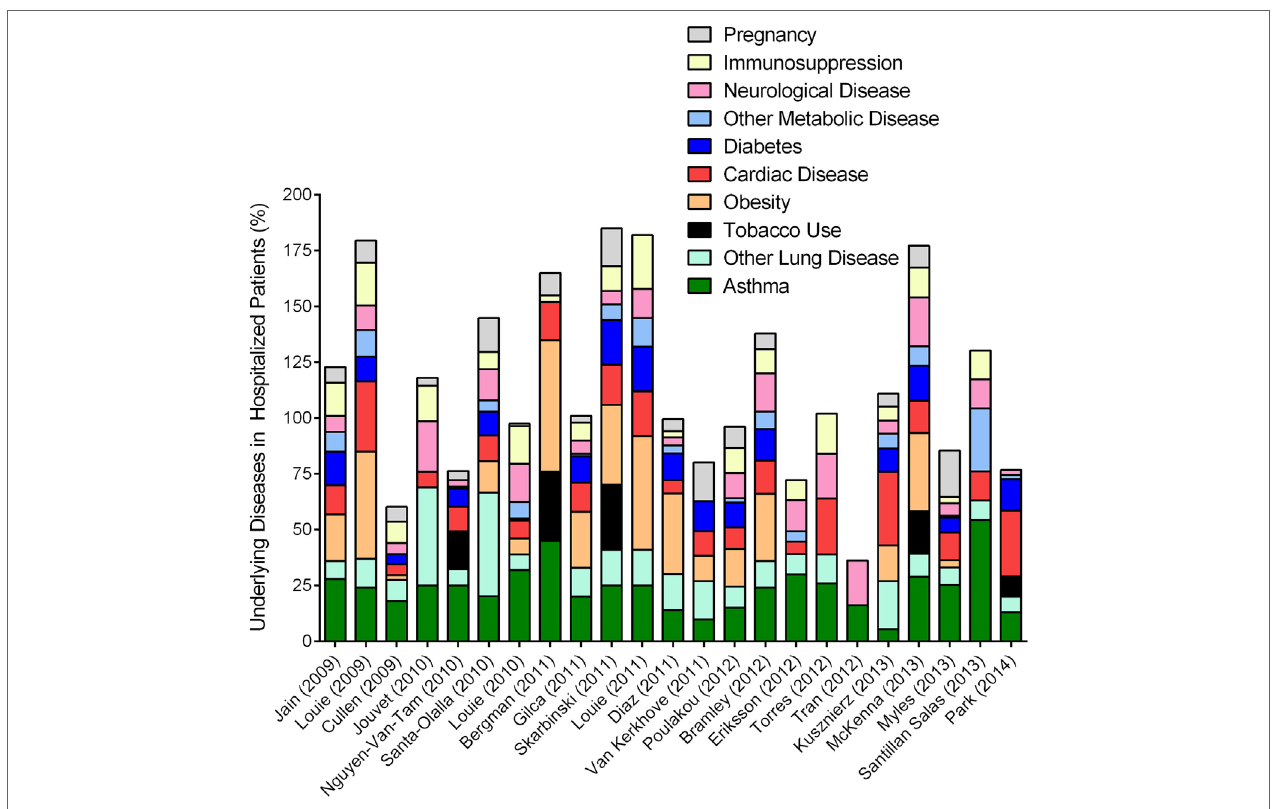
FiGURe 4 | Overview of epidemiologic reports surrounding 2009 pandemic influenza in asthmatics. Epidemiologic findings reporting on the outcome of pandemic influenza in cohorts that included asthmatics were mined to calculate the percentages of patients with other reported diseases. Data from each manuscript were graphed to show the distribution of morbidities in patients hospitalized during the 2009 influenza pandemic. Values accounting for > 100% indicate that patients within the cohort had multiple underlying disease